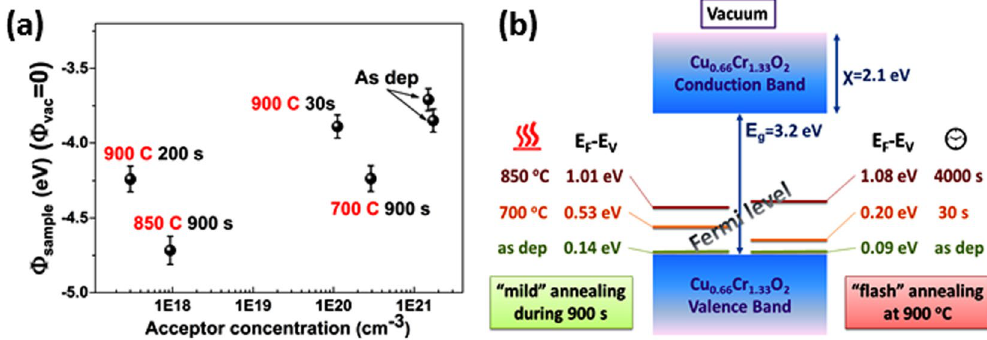
Figure 4. ( a ) work-function difference as a function of the carrier concentration); (b) calculated Fermi level for delafossite film annealing at different temperatures and for various time